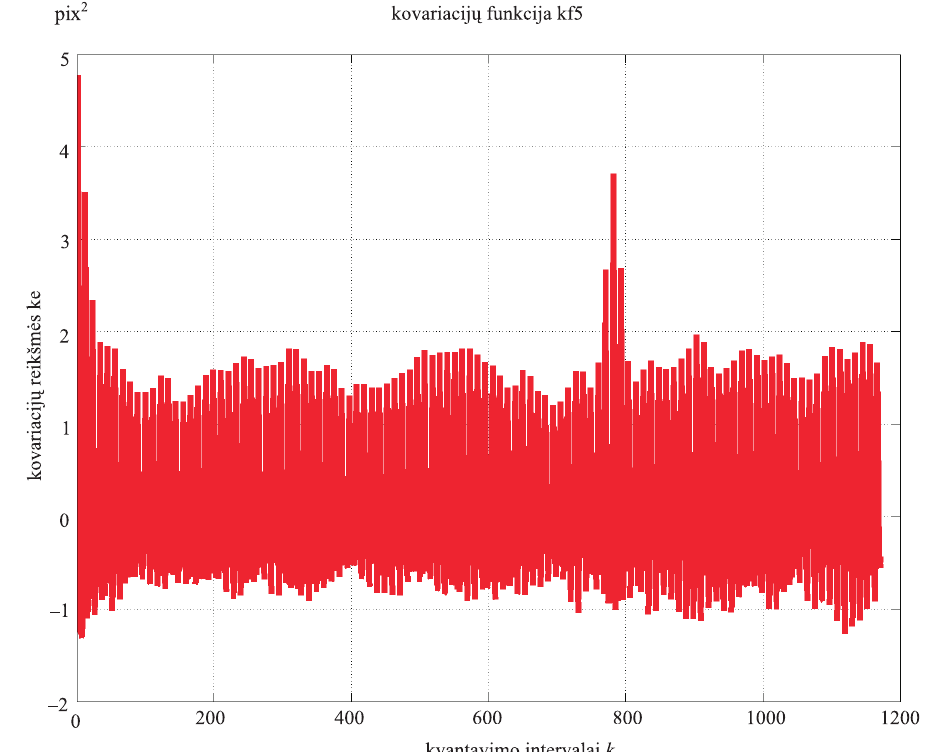
Fig. 3. Graphic of the covariance function of a single scale by the moving quantation interval